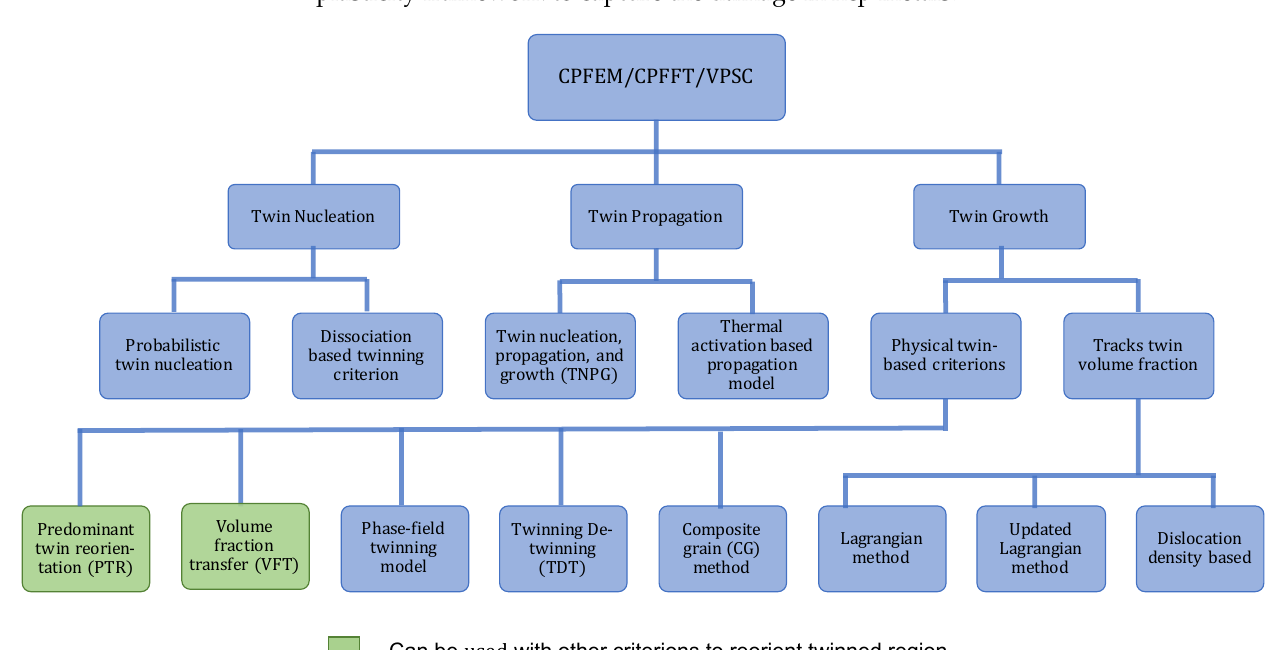
Figure 14. Hierarchy showing how different twinning criteria fit with twinning mechanisms in crystal plasticity (CP)